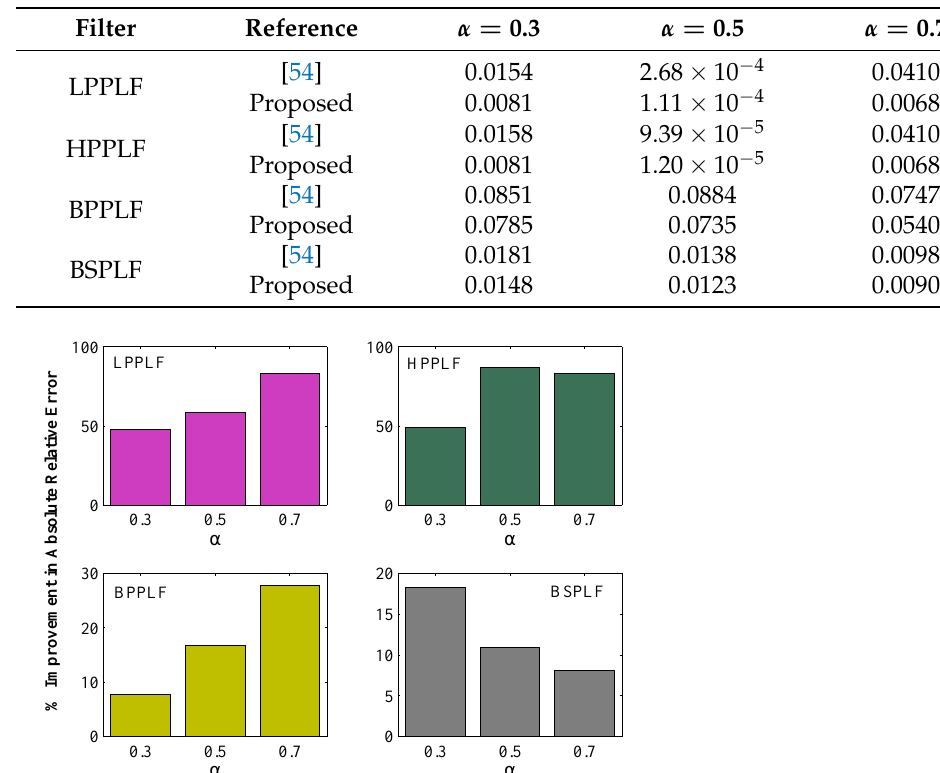
Table 4. Comparison of the most accurate proposed PLFs with the published literature [54] in terms of the MARE metric.